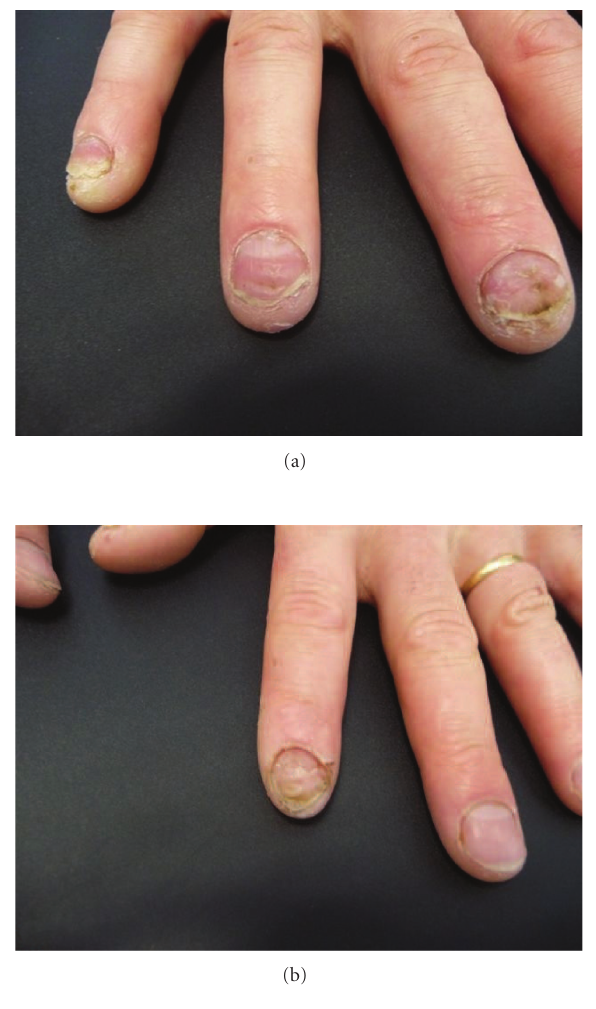
Figure 1: Subungual hyperkeratosis, pitting, and onycholysis of right-hand fingernails 3, 4, and 5 (a) and of left-hand fingernail 2